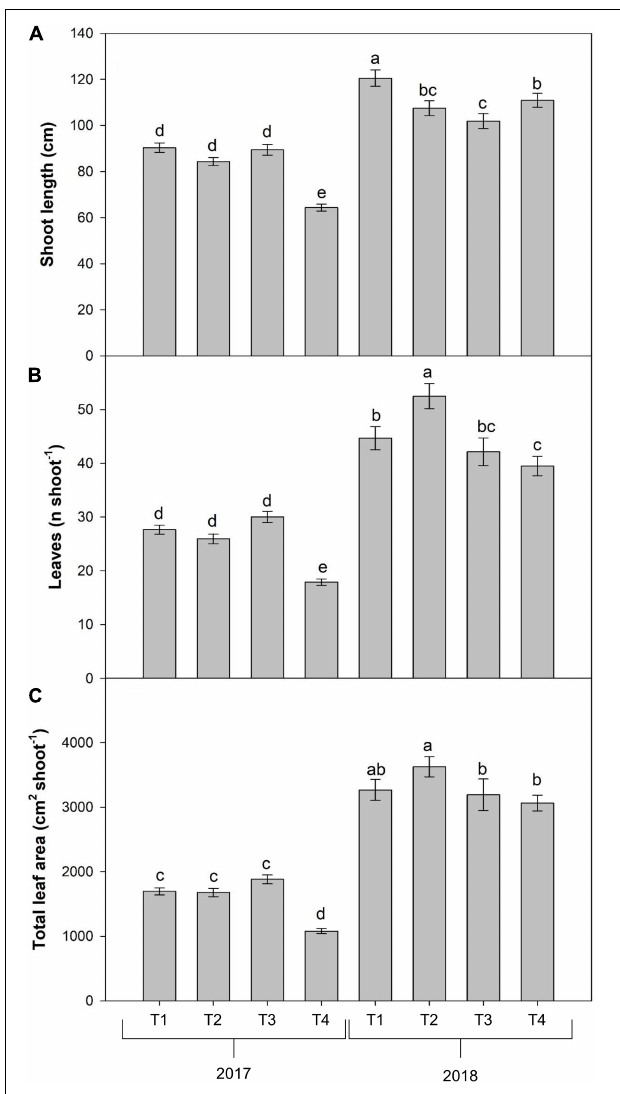
FIGURE 2 | Combined effects of year and foliar treatments shoot length (A) , leaf number (B) and total leaf area (C) per shoot of V. vinifera “Aglianico” vines (mean ± SE). Different letters indicate significant differences according to Duncan’s multiple-range test ( P ≤ 0.05). [T1 – only industry water mixture of copper oxychloride; T2 – industry water mixture of copper oxychloride plus Trym R (cid:13) ; T3 – half dose of copper oxychloride water mixture; T4 – half dose of copper oxychloride water mixture plus Trym R (cid:13)